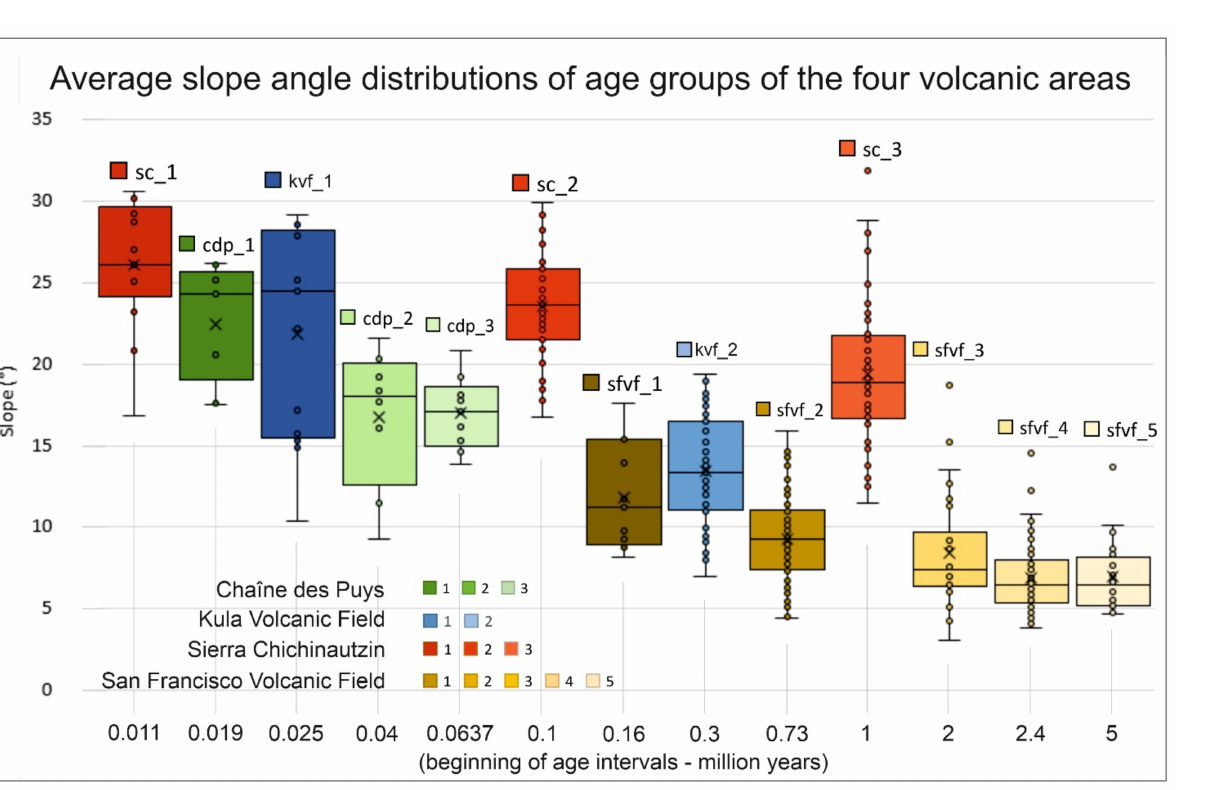
Figure 11. Boxplot diagram of the average slope values of all the four areas and all age groups: Chichinautzin (SC) is marked with reddish shades, Chaîne des Puys (CdP) with greenish, Kula (KVF) with bluish, and San Francisco (SFVF) with brownish-yellowish. Age groups are arranged in increasing order (starting with the